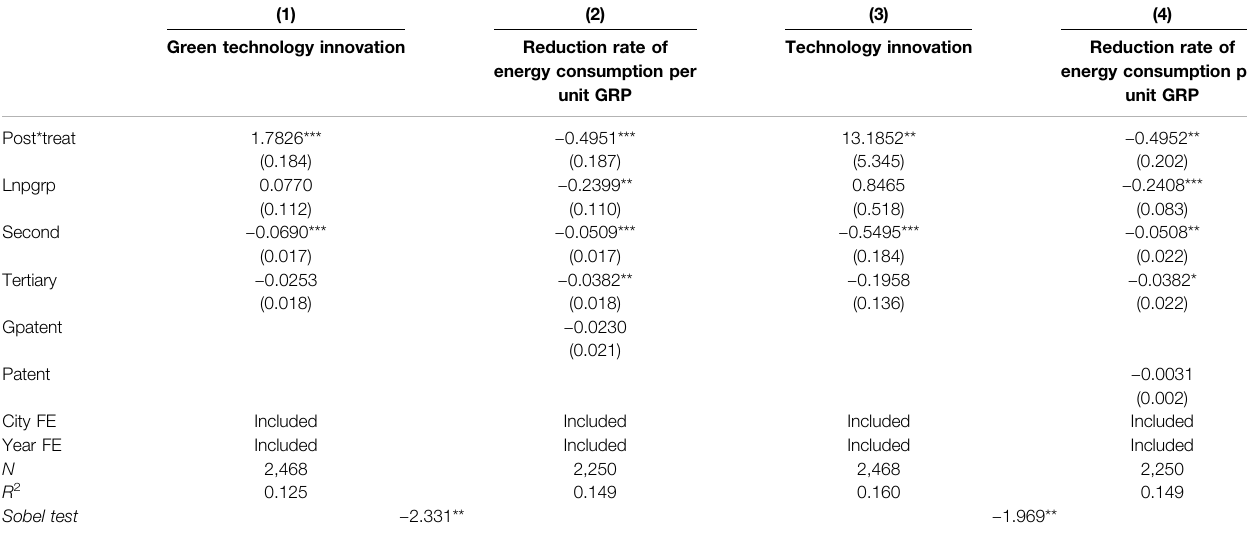
TABLE 9 | The technological innovation mechanisms of low-carbon city pilot policy.